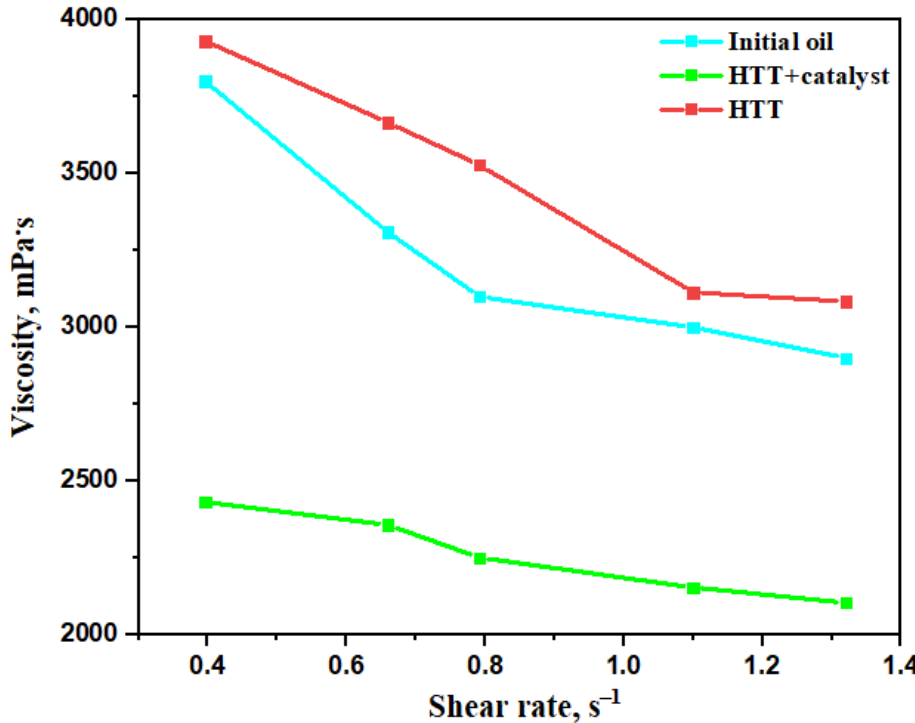
Figure 7. The shear rate-dependent viscosity values for initial and upgraded heavy oil samples.